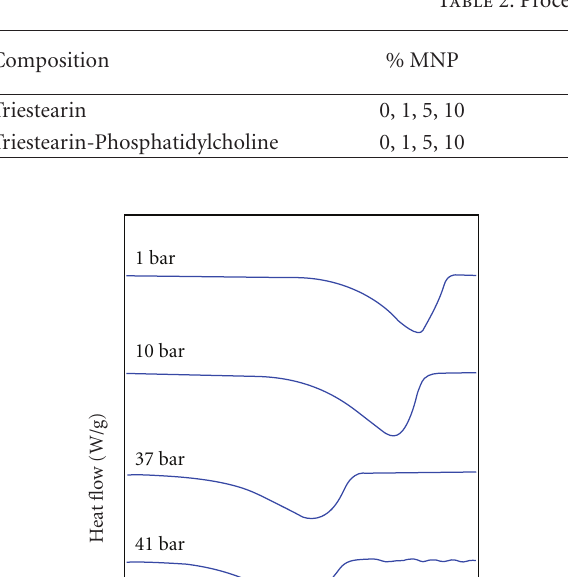
Table 2: Process operative conditions.